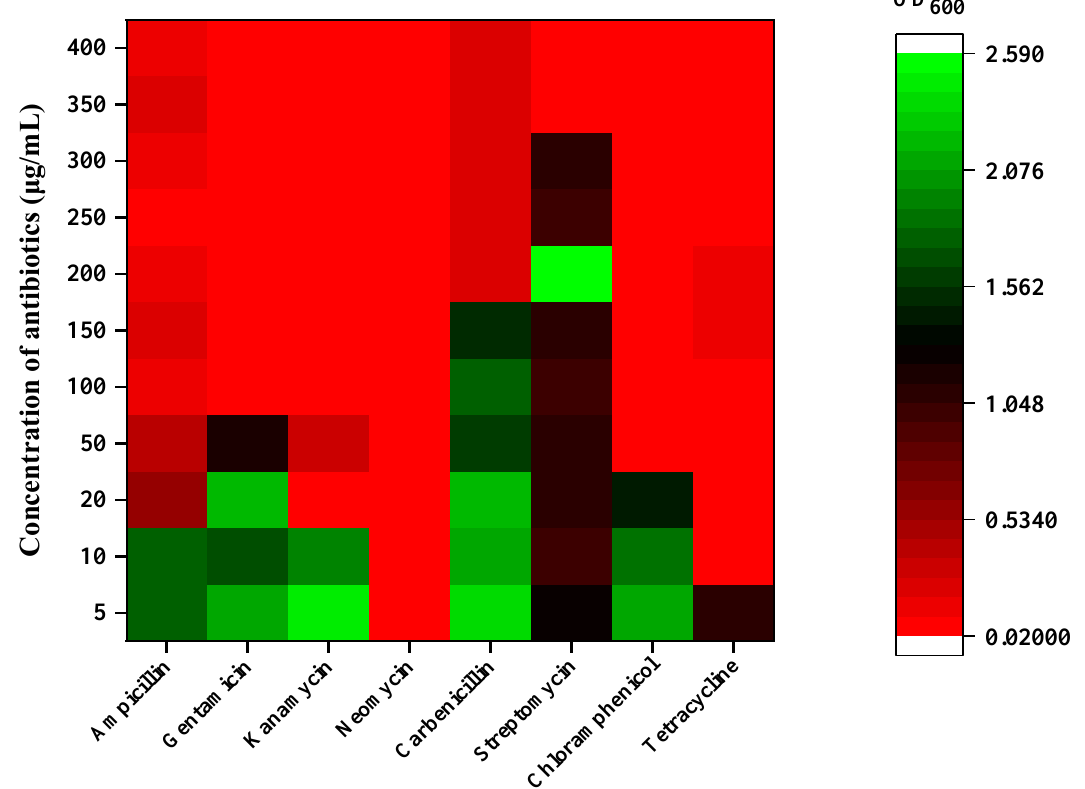
Figure 3. Antibiotic sensitivity of strain XN-10. This figure shows the results of the sensitivity of strain XN-10 to various concentrations of each antibiotic. The green in the figure indicates that the strain has strong resistance to this concentration of antibiotics, and the red indicates that the strain is susceptible to this concentration of antibiotics.